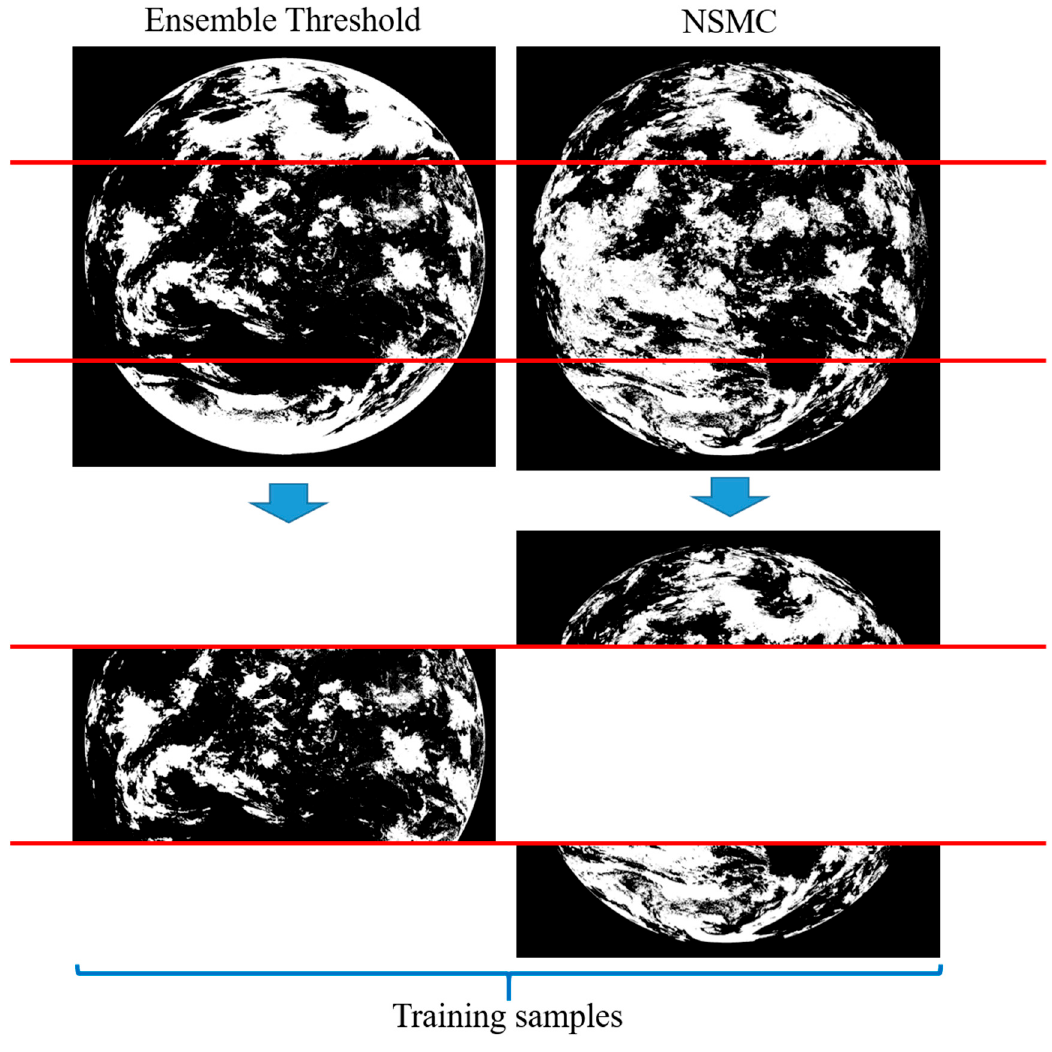
Figure 5. The training sample selection